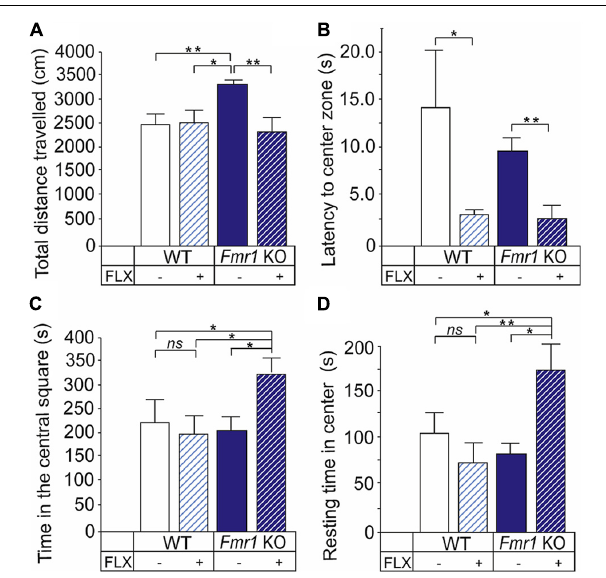
FIGURE 1 |Altered behavioral responses to fluoxetine of Fmr1 KO mice in the open field test. (A) Fmr1 KO mice ( Fmr1 KO) show locomotor hyperactivity seen as longer distance traveled by the mice when compared with wild-type controls (WT).The locomotor activity of Fmr1 KO mice was decreased to the level ofWT mice after treatment with fluoxetine. (B) Fluoxetine reduced the latency to enter the center area of the open field in bothWT and Fmr1 KO mice. (C) Fluoxetine increased the time that Fmr1 KO mice spent in the central square but did not have any effects on this behavior inWT mice. (D) The resting time in center was increased by fluoxetine in Fmr1 KO mice. Error bars indicate means + SEM. * P < 0.05, ** P <